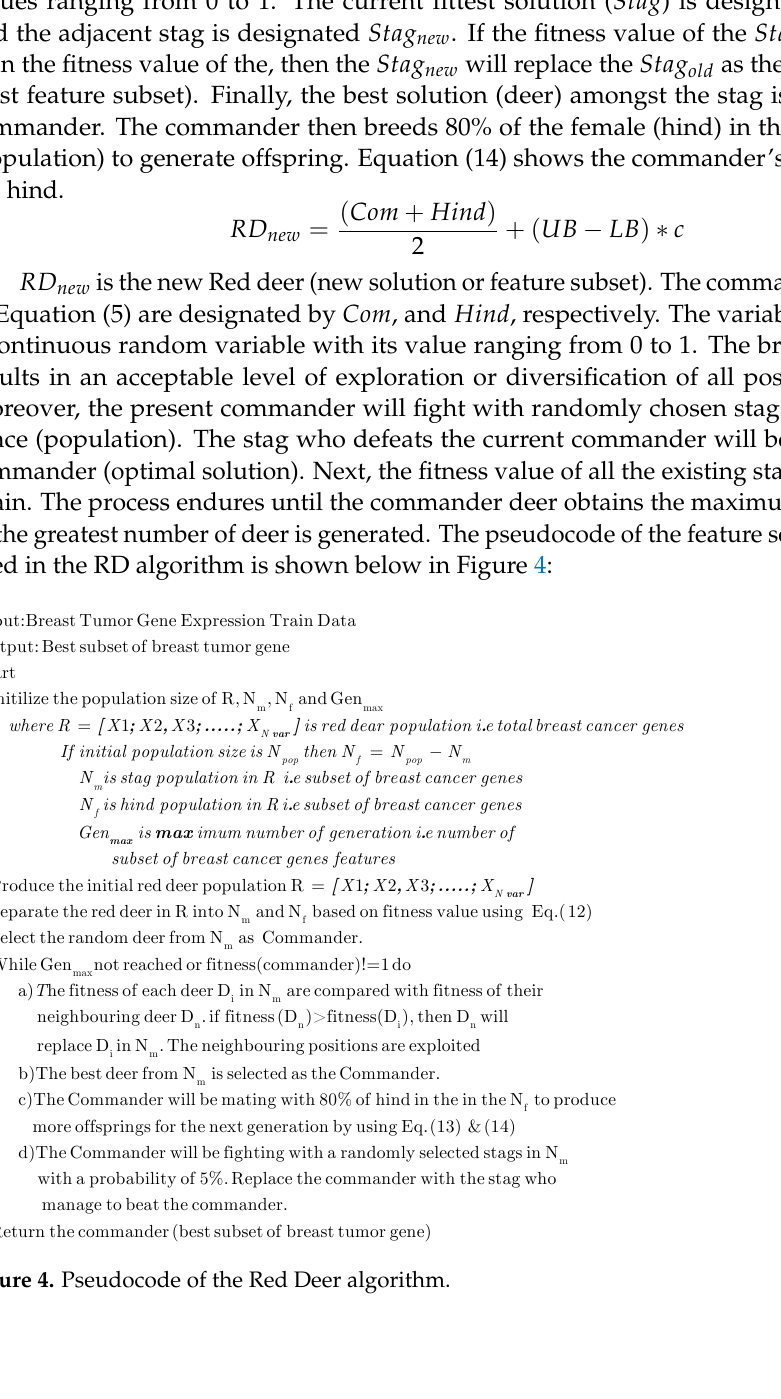
Table 3. Feature selection methods' parameter settings.